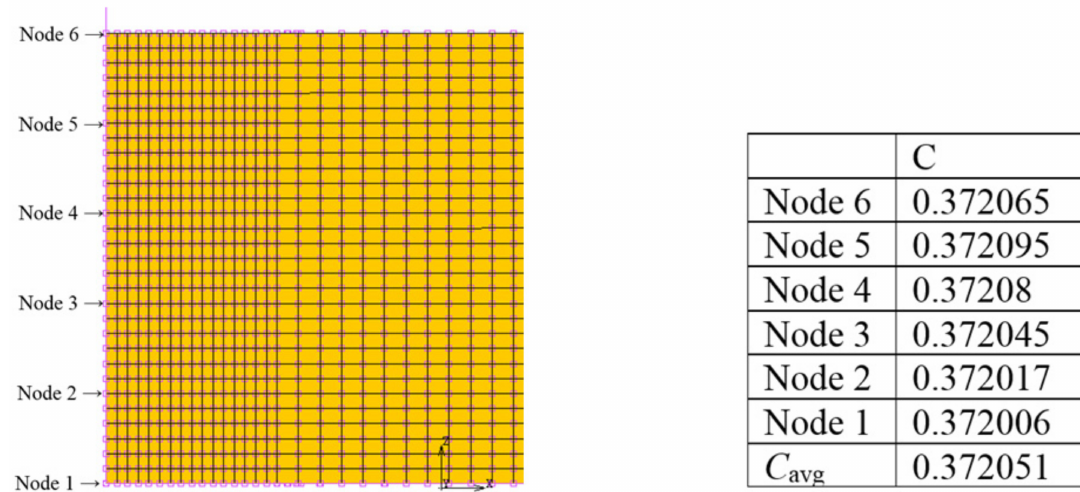
Figure 16. Nodes for which Cockroft–Latham damage indicator was calculated.